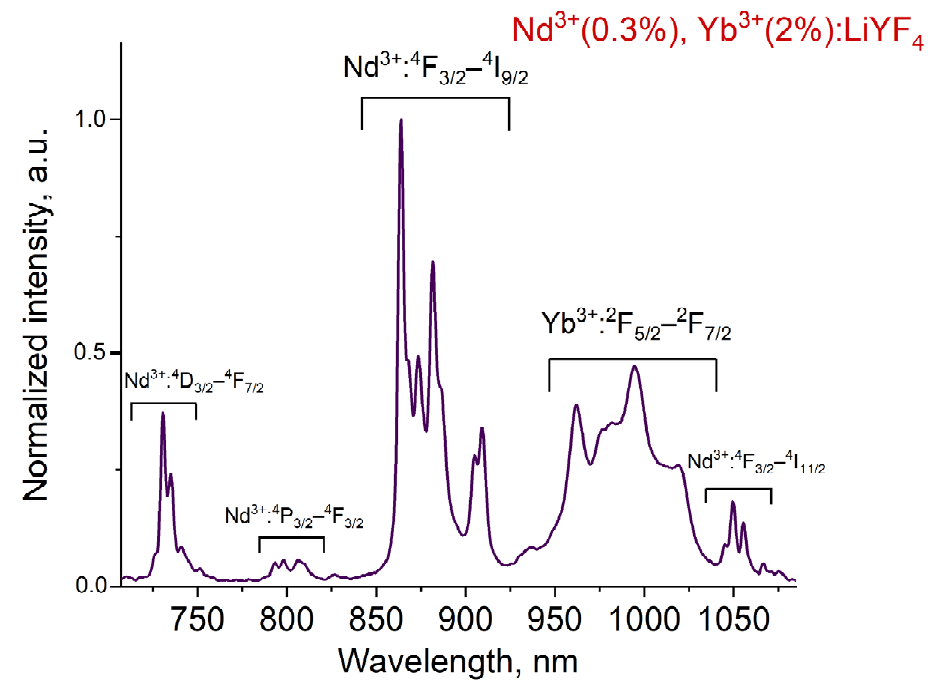
Figure 3. The room temperature spectrum of Nd 3+ (0.3%), Yb 3+ (2.0%): LiYF 4 phosphors normalized at 866 nm. The excitation λ ex = 355 nm corresponds to 4 I 9/2 – 4 D 5/2 of Nd 3+ absorption band. The spectrum illustrates the presence of 4 D 5/2 , 4 P 3/2 – 4 F J transitions.